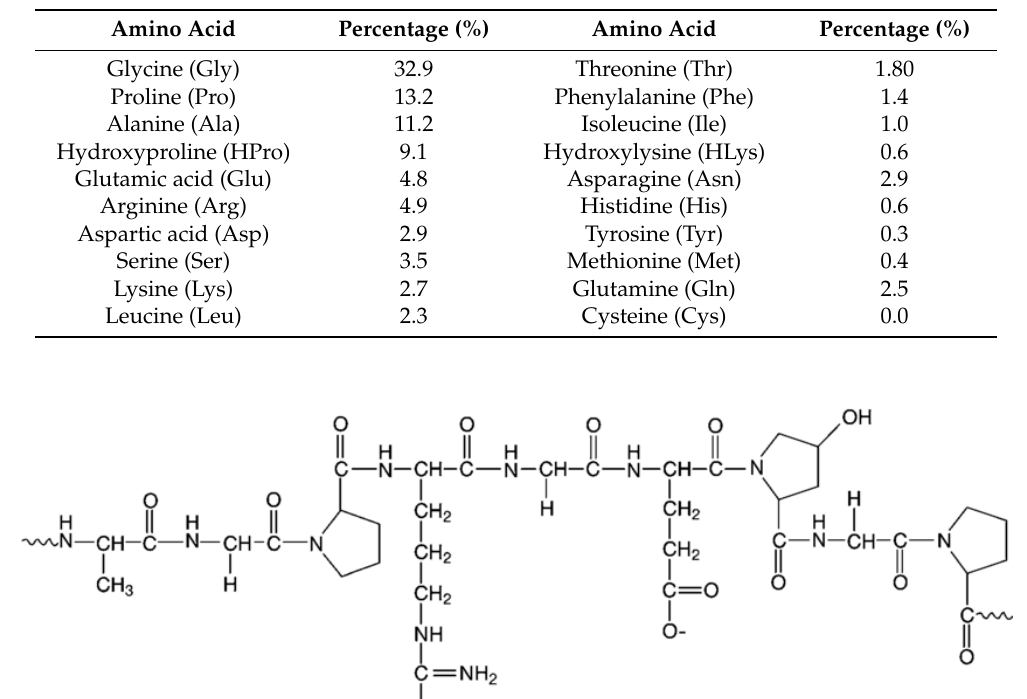
Figure 2. One of the representative gelatin peptide sequences Ala-Gly-Pro-Arg-Gly-Glu-Hyp-Gly- Pro.